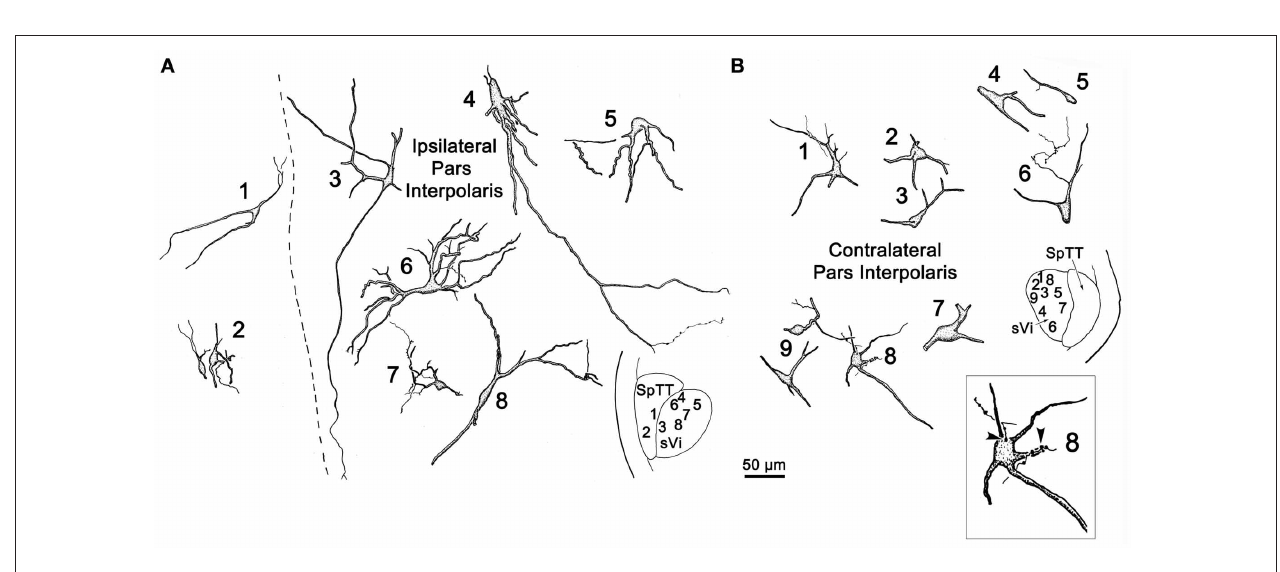
FIGURE 3 | Retrogradely labeled neurons and anterogradely labeled axons within sVi on the ipsilateral (A) and contralateral (B) side following the injection illustrated in Figure 2A. The location of the